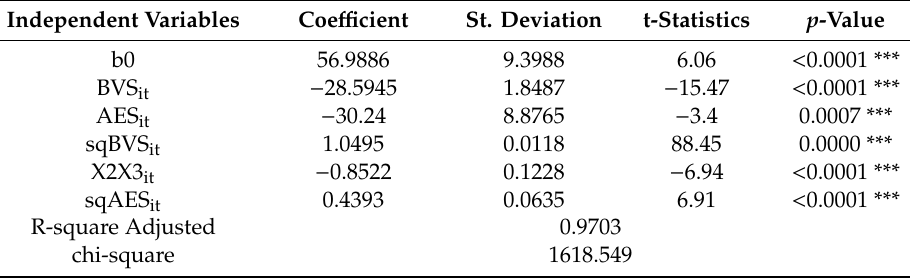
Table 2. White’s OLS heteroscedasticity